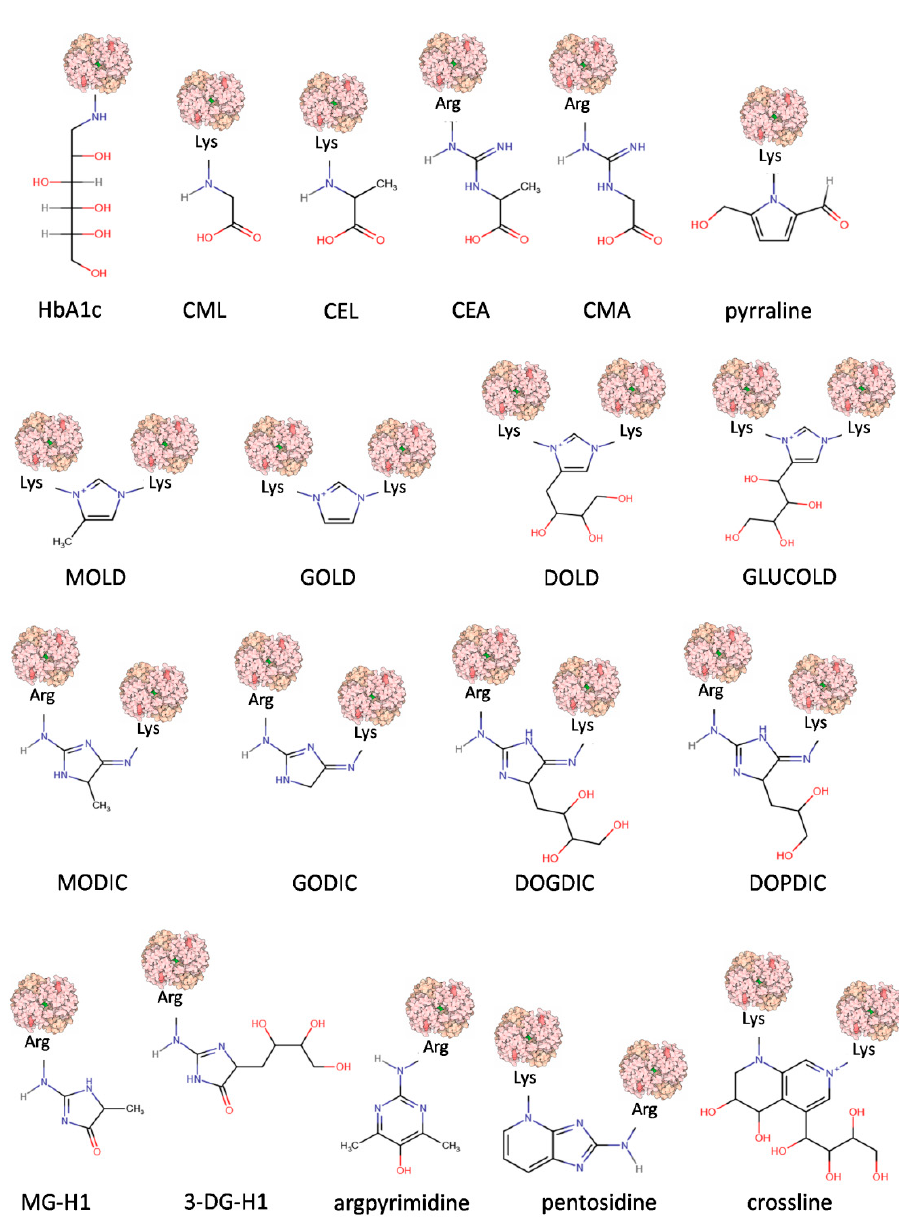
Figure 2. Chemical structure representations of AGEs. Abbreviations: glycated hemoglobin (HbA1c), N ε –(carboxymethyl)lysine (CML), N ε ‐ (1 ‐ carboxyethyl)lysine (CEL), N 7 –(1 ‐ carboxyethyl) arginine (CEA), N 7 –(carboxymethyl)arginine (CMA), 6 ‐ (2 ‐ formyl ‐ 5 ‐ hydroxymethyl ‐ 1 ‐ pyrrolyl) ‐ L ‐ norleucine (pyrraline), 6 ‐ {1 ‐ [(5S) ‐ 5 ‐ ammonio ‐ 6 ‐ oxido ‐ 6 ‐ oxohexyl] ‐ 4 ‐ methyl ‐ imidazolium ‐ 3 ‐ yl} ‐ L ‐ norleucine (MOLD), 6 ‐ {1 ‐ [(5S) ‐ 5 ‐ ammonio ‐ 6 ‐ oxido ‐ 6 ‐ oxohexyl]imidazolium ‐ 3 ‐ yl} ‐ L ‐ norleucine (GOLD),1,3 ‐ di(N ε ‐ lysino) ‐ 4 ‐ (2,3,4 ‐ trihydroxybutyl) ‐ imidazolium (DOLD),1,3 ‐ bis ‐ (5 ‐ amino ‐ 5 ‐ carboxypentyl) ‐ 4 ‐ (1,2,3,4 ‐ tetrahydroxybutyl) ‐ 3H ‐ imidazolium (GLUCOLD), 2 ‐ ammonio ‐ 6 ‐ ({2 ‐ [4 ‐ ammonio ‐ 5 ‐ oxido ‐ 5 ‐ oxopently)amino]4 ‐ methyl ‐ 4,5 ‐ dihydro ‐ 1H ‐ imidazol ‐ 5 ‐ ylidene}amino) hexanoate (MODIC), N 6 ‐ (2 ‐ {4S( ‐ 4 ‐ ammonio ‐ 5 ‐ oxido ‐ 5 ‐ oxopentyl]amino} ‐ 3,5 ‐ dihydro ‐ 4H ‐ imidazol ‐ 4 ‐ ylidene) ‐ L ‐ lysine (GODIC), N 6 ‐ {2 ‐ {[(4S) ‐ 4 ‐ ammonio ‐ 5 ‐ oxido ‐ 5 ‐ oxopentyl]amino} ‐ 5 ‐ [(2S,3R) ‐ 2,3,4 ‐ trihydroxybutyl] ‐ 3,5 ‐ dihydro ‐ 4H ‐ imidazol ‐ 4 ‐ ylidene} ‐ L ‐ lysinate (DOGDIC), N 6 ‐ {2 ‐ {[(4S) ‐ 4 ‐ ammonio ‐ 5 ‐ oxido ‐ 5 ‐ oxopentyl]amino} ‐ 5 ‐ [(2S) ‐ 2,3 ‐ dixydroxypropyl]3,5 ‐ dihydro ‐ 4H ‐ imidazol ‐ 4 ‐ ylidene} ‐ L ‐ lysinate (DOPDIC), N δ ‐ (5 ‐ methyl ‐ 4 ‐ imidazolon ‐ 2 ‐ yl) ‐ L ‐ ornithine (MG ‐ H1), N δ ‐ (45 ‐ hydro ‐ 5 ‐ (2,3,4 ‐ trihydroxybutyl) ‐ 4 ‐ imidazolon ‐ 2 ‐ yl] ‐ L ‐ ornithine (3DG ‐ H1), N δ ‐ (5 ‐ hydroxy ‐ 4,6 ‐ dimethylpyrimidine ‐ 2 ‐ yl) ‐ L ‐ ornithine (argpyrimidine), and 6 ‐ [2 ‐ [[(4S) ‐ 4 ‐ amino ‐ 5 ‐ hydroxy ‐ 5 ‐ oxopentyl]amino] ‐ 4 ‐ imidazo[4,5 ‐ b]pyridinyl] ‐ L ‐ norleucine (pentosidine). Modified protein surface models (light pink) are based on the structure of human hemoglobin (PDB ID 1COH).